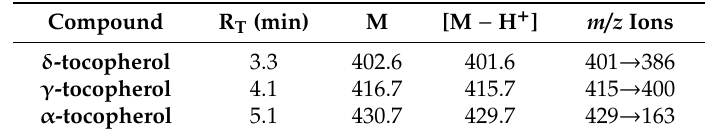
Table 1. Detection parameters for tocopherols determined by liquid chromatographic method coupled with mass spectrometry in tandem (LC-MS / MS). Compound